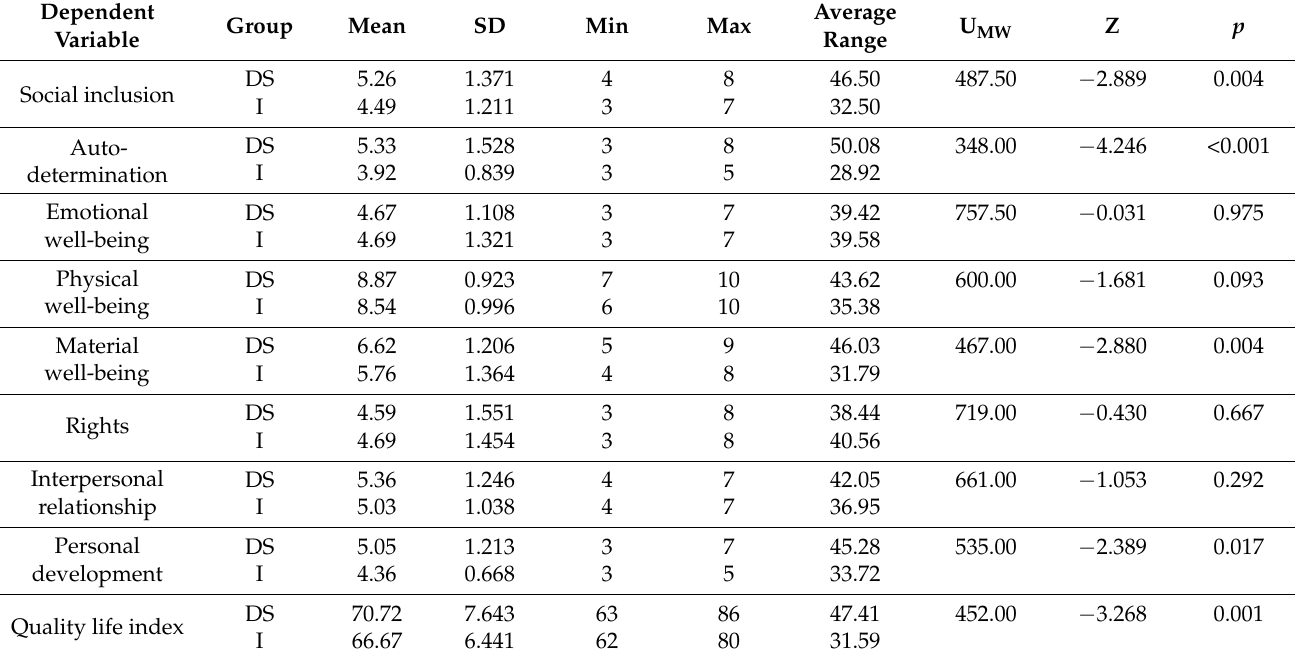
Table 6. Mann–Whitney U -tests for dependent variables studied with respect to groups (participants with DS, n = 39; Informants, n =